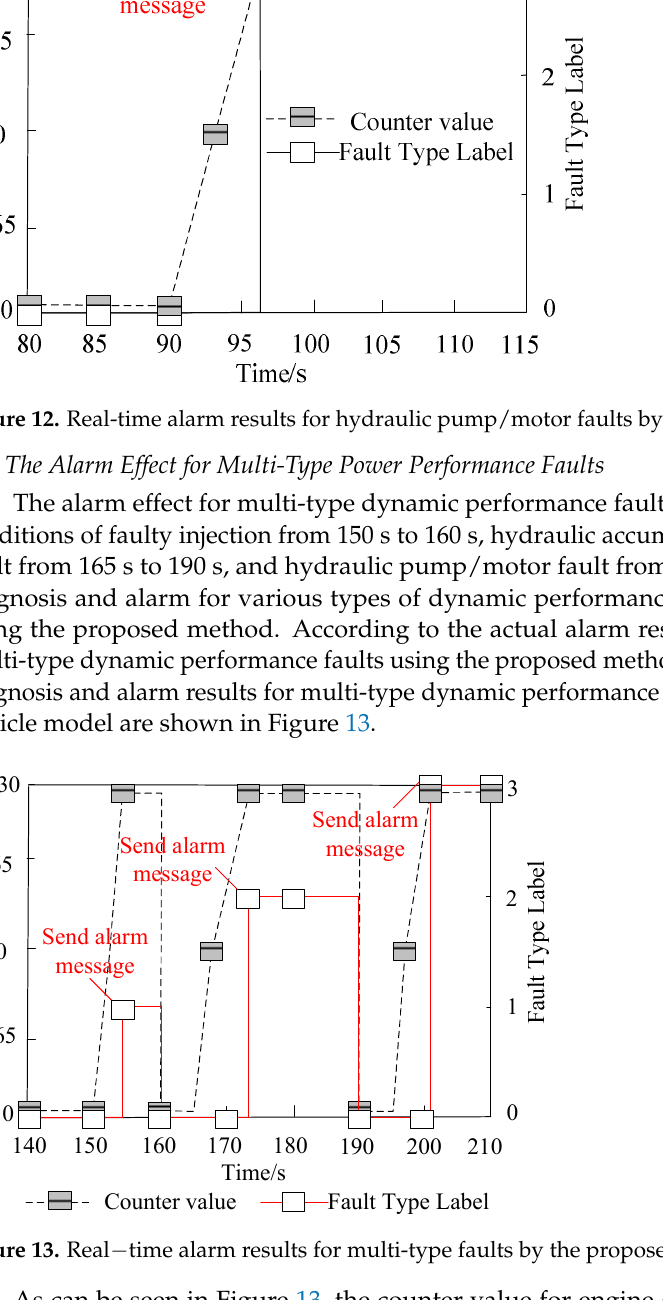
Figure 13. Real−time alarm results for multi-type faults by the proposed method. Figure 13. Real − time alarm results for multi-type faults by the proposed